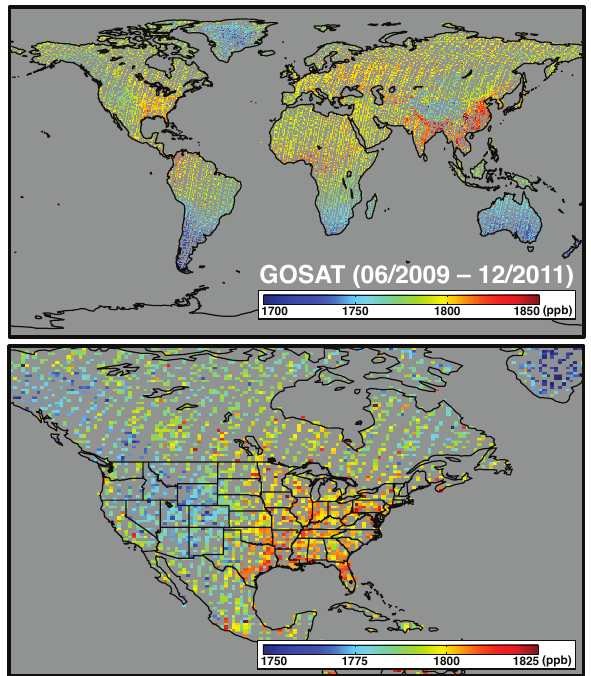
Figure 1. Mean GOSAT observations of the weighted column- average methane dry-mole fraction ( X CH December 2011, globally and for North America. The data are ver- sion 4 proxy methane retrievals from Parker et al. (2011) that pass all quality flags (http://www.leos.le.ac.uk/GHG/data/styled/index.